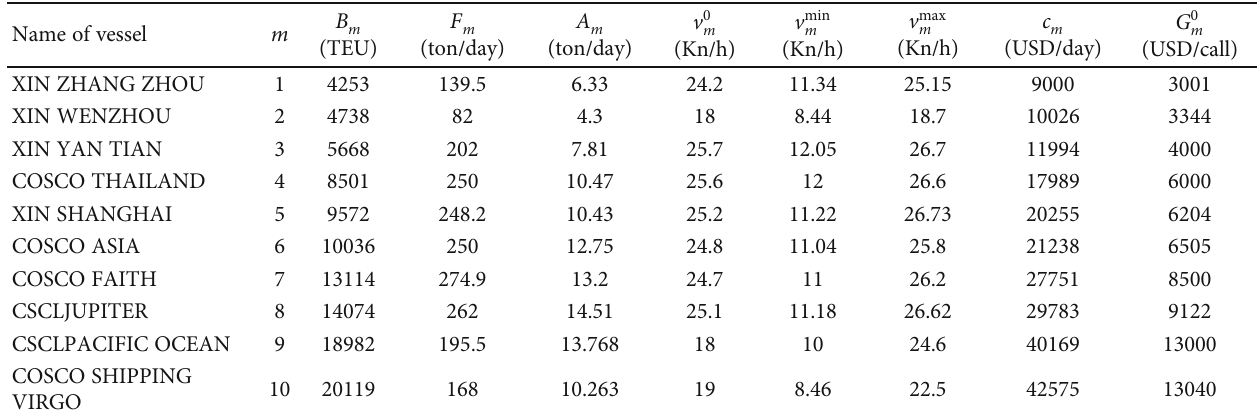
Figure 2: The European route of COSCO SHIPPING. Table 1: Data of each ship